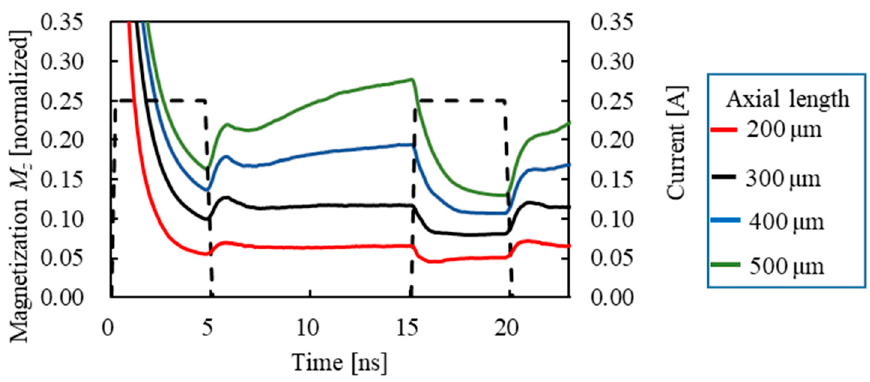
Figure 11. Time dependence of magnetization in the z-axis direction (axial direction).